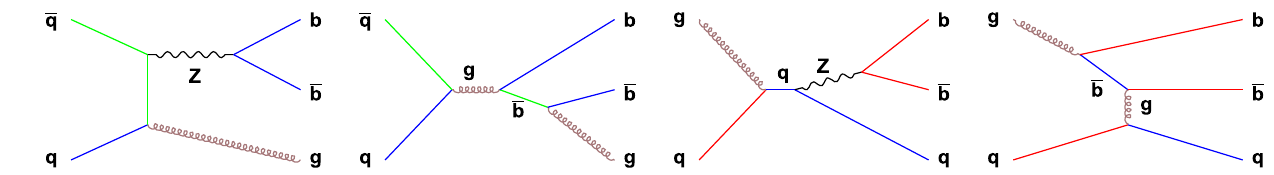
Fig. 6 Feynman diagrams showing the production of a qq pair recoiling against either a quark or a gluon. The QCD examples drawn are selected such that they can exhibit interference Table 4 Interference effects on the Z and W boson peaks with an ini- tial state of either qg plus qg or qq and separated by final state quark flavour. Signal-to-background is defined at the resonance peak with-